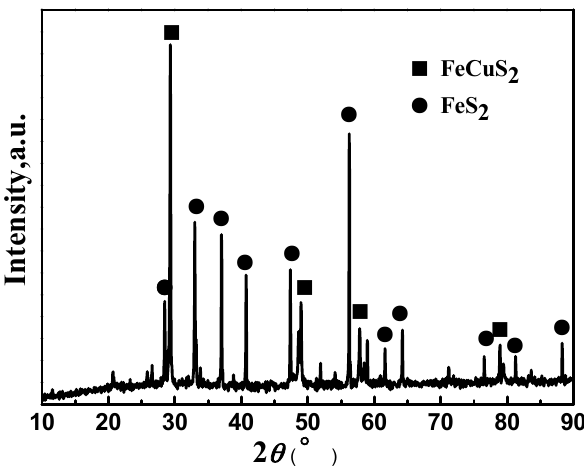
Figure 1. X-ray diffraction (XRD) pattern of the mineral samples .